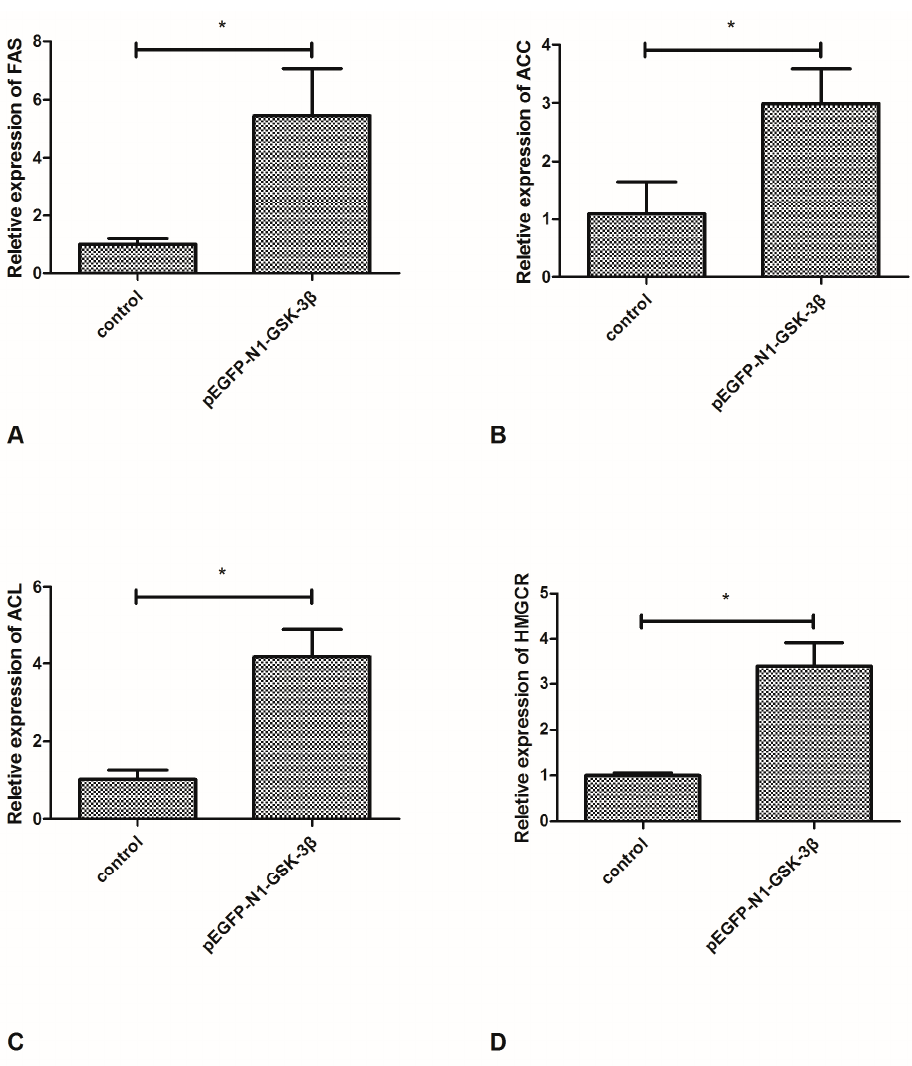
Figure 3. Effect of the pEGFP-N1-GSK-3 β vector on the mRNA expression of FAS, ACC, ACL, and HMGCR in the muscle of zebrafish. ( A ) FAS; ( B ) ACC; ( C ) ACL; ( D ) HMGCR. Values are expressed as means ± s.e.m. ( n = 6). Statistically significant differences are denoted by asterisk ( p <